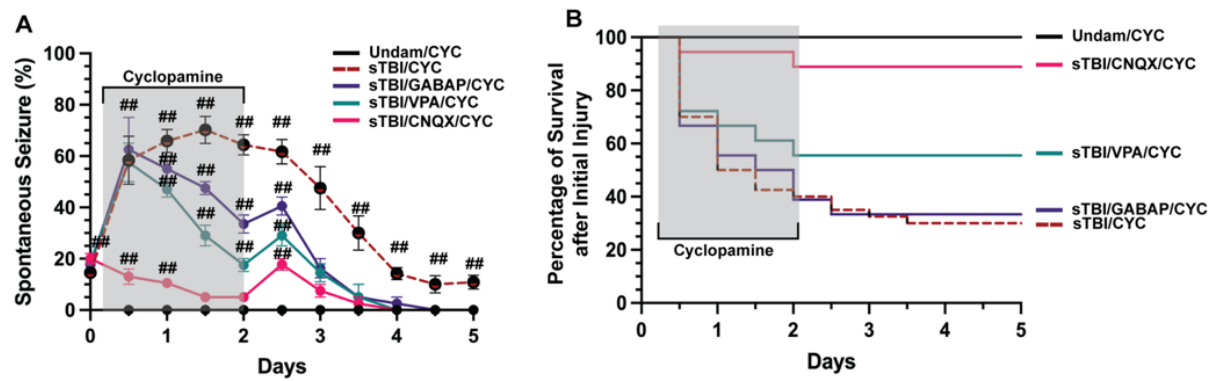
Figure 3. CNQX attenuates PTS in Shh-inhibited fish. ( A ) Percentage of undamaged and sTBI that were Shh inhibited (cyclopamine-treated) and cotreated with either valproic acid (VPA), gabapentin (GABAP), or CNQX that displayed spontaneous seizure events across 5 dpi. ( B ) Quantification of survival across 5 days of undamaged or sTBI Shh-inhibited fish cotreated with VPA, GABAP, or CNQX. Statistical analysis of the repeated-measures data was performed with the Friedman test, n = 100 fish per control/experimental group, grey box denotes period of cyclopamine/(VPA or GABAP or CNQX) administration, ## p <